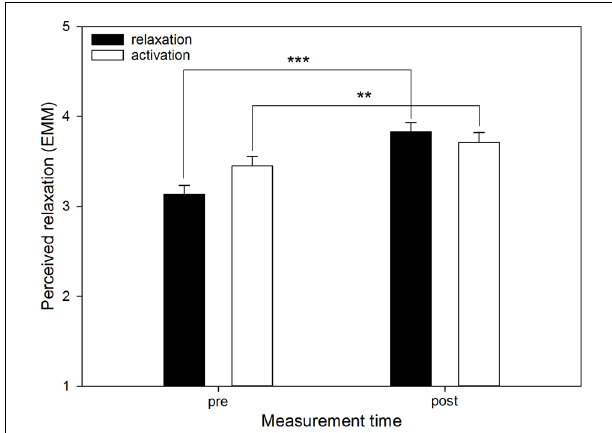
FIGURE 4 | Perceived relaxation by listening aim before and after using the app. The graph shows the EMM of perceived relaxation before (pre) and after (post) using the app, separated by the two aims (“relaxation,” “activation”). Error bars represent standard errors of EMM. There were significant increases if “relaxation” and “activation” had been selected as the aim. However, the increase for the aim relaxation was clearer. Sessions conducted in the mode “language” were not included in the data, because in this mode there was no option of selecting an aim. ∗∗ p < 0.01, ∗∗∗ p < 0.001.